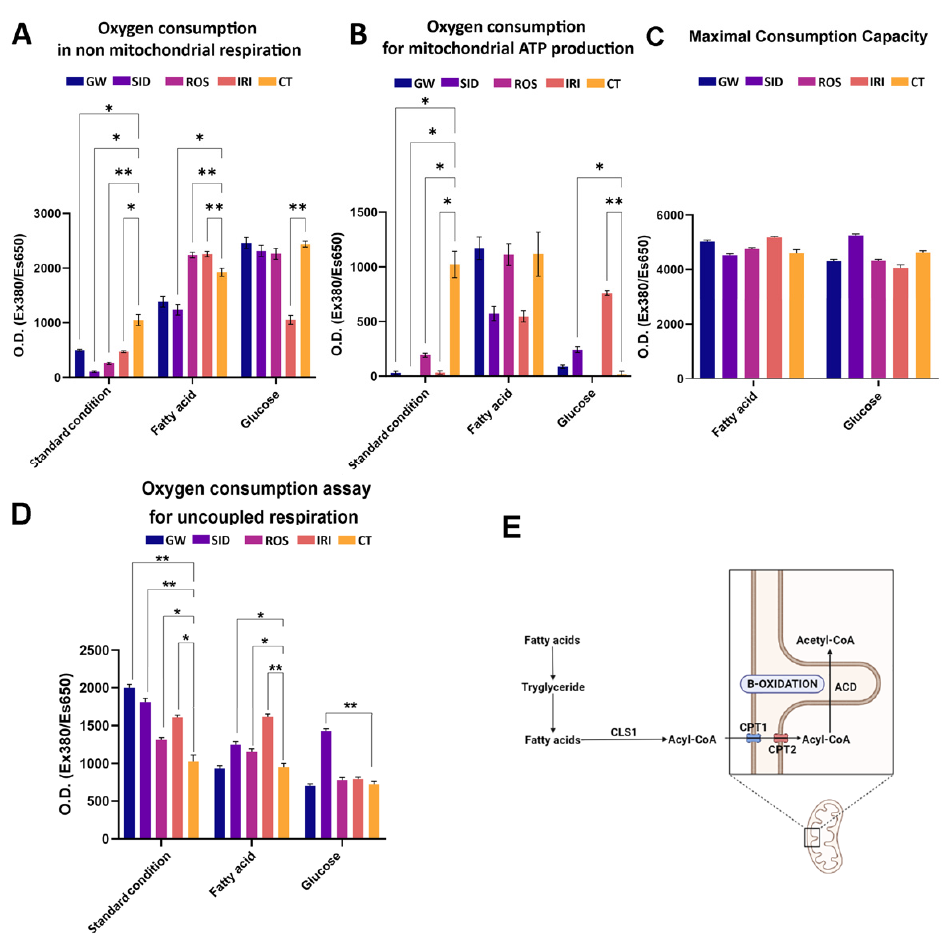
Figure 4. Evaluation of cellular mitochondrial function by oxygen consumption assay. ( A ): Basal oxygen consumption rate. Oxygen consumption rates (OCR) in non-mitochondrial respiration was measured by MitoXpress ® Xtra assay in white adipocytes treated with browning agents. Cells were incubated in complete medium (basal condition). The histogram shows optical density (O.D Ex380/Es650 nm) ( ± SD, n = 3 biological replicates; * p < 0.05, ** p < 0.01). ( B ): OCR for mitochondrial ATP production. (* p < 0.05, ** p < 0.01). ( C ): OCR for maximal respiratory capacity. ( D ): OCR for uncoupled respiration. OCR was measured according to protocol described in the methods section. Cells were incubated in complete medium (basal condition), or medium containing only palmitate (fatty acid), or medium containing only glucose (glucose). The histogram shows optical density (O.D Ex380/Es650 nm) ( ± SD, n = 3 biological replicates; * p < 0.05, ** p < 0.01). ( E ): A scheme to explain supposed futile lipogenic pathway with fatty acid and triglyceride formation, succeeded by triglyceride lysis and oxidation of free fatty acids. In particular, three enzymes, DGAT2, LIPIN1, and AGPAT2 generate triglycerides from fatty acids. These are subjected to the lysis in cytosolic lipid droplets by ATGL, HSL, and MGL. The released fatty acids can both activate UCP1 to produce heat or be transformed into acetyl-CoA by ACSL1 and shuttled into the mitochondria across the translocator CPT1and CPT2. Here they are submitted to beta-oxidation via ACD, to produce mitochondrial proton leaks (thermogenesis). GW: GW501516; SID: sildenafil; ROS: rosiglitazone; IRI: irisin; CT: differentiated white adipocytes without analyzed drugs. Drug concentration: 1 nM (GW); 1 nM (SID); 43 nM (ROS); 20 nM